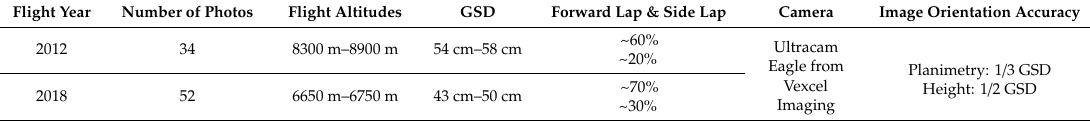
Table 2. Main specifications of the photogrammetric flight missions from 2012 and